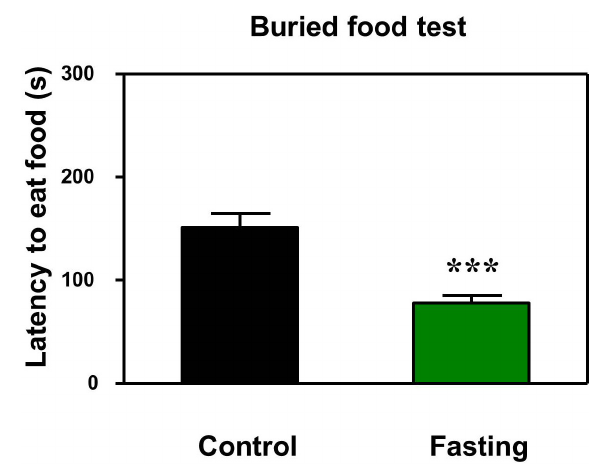
FIGURE 2 | Acute fasting enhances the natural behavior of mice in buried food test. The bar graphs show that acute fasting for 9 h (green column) significantly decreases the latency to eat the food of the mice as compared to the control condition (black column) in the buried food test. Data are shown as means ± SEM (Mann-Whitney test; ∗∗∗ p < 0.001; n = 12–16